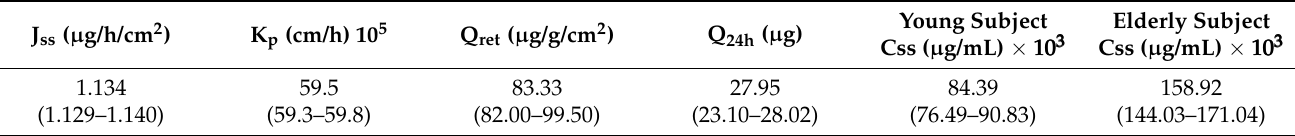
Table 3. Permeation parameters obtained after ex vivo study. Predicted steady-state plasma concen- tration (C ss ) of the PF after application of the formulation on 100 cm 2 of skin. Results are reported as the median, minimum, and maximum range values. The data were obtained from the mean of six experiments ( n = 6).